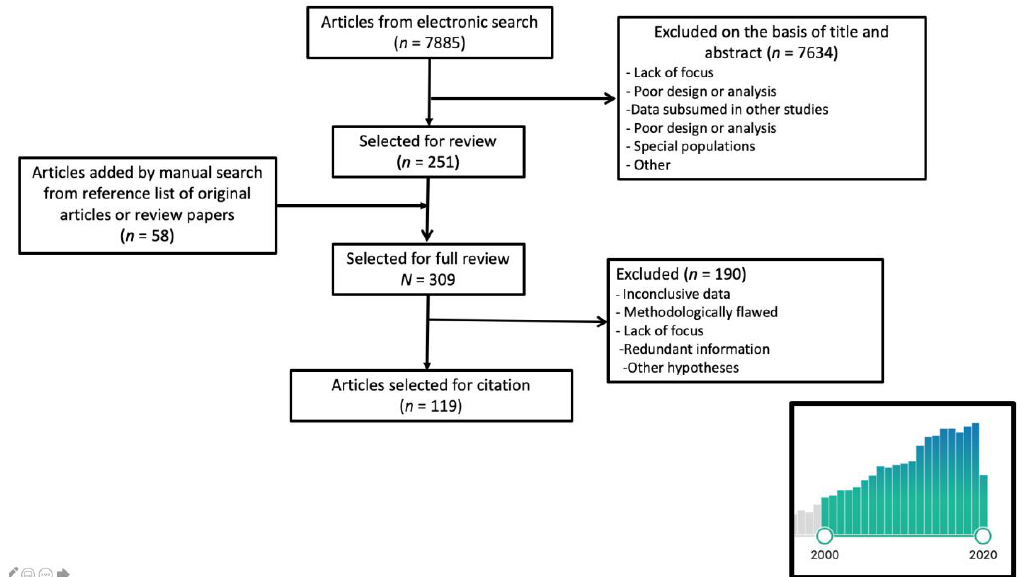
Figure 1. Literature search flowchart. The bars in the insert represent the trend in the numbers of papers published per year between 2000 and 2020. The year 2020 is incomplete because the search only included papers published until 1